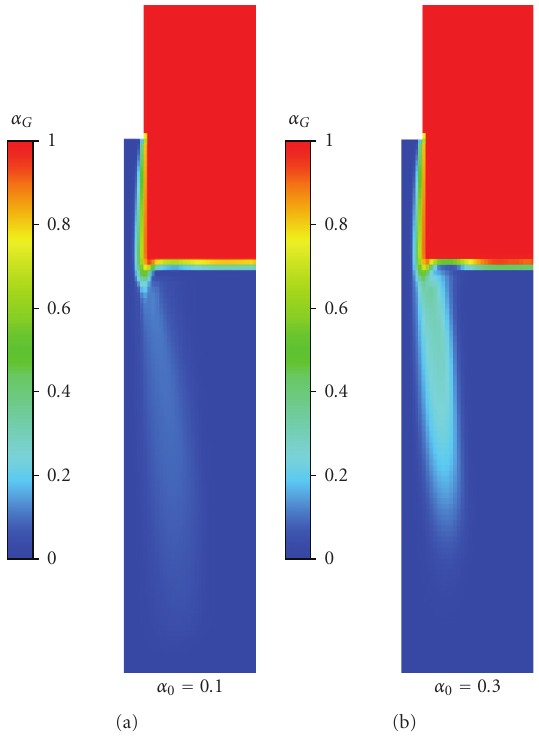
Figure 19: Gas void fraction for C D , S = 0 . 1 and various α 0 .